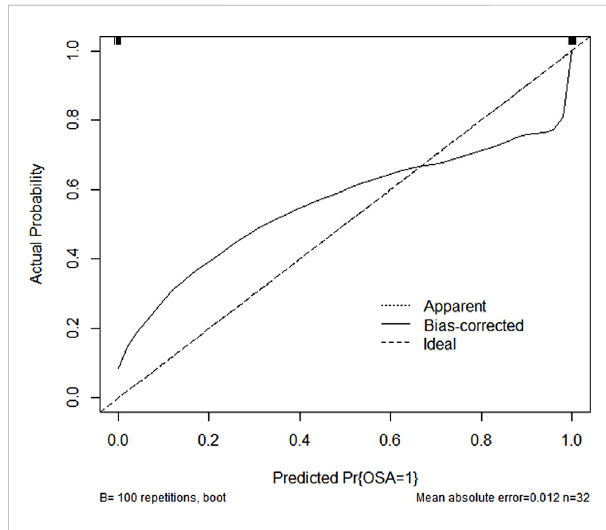
FIGURE 11 Calibration curve of nomogram in external validation cohort.